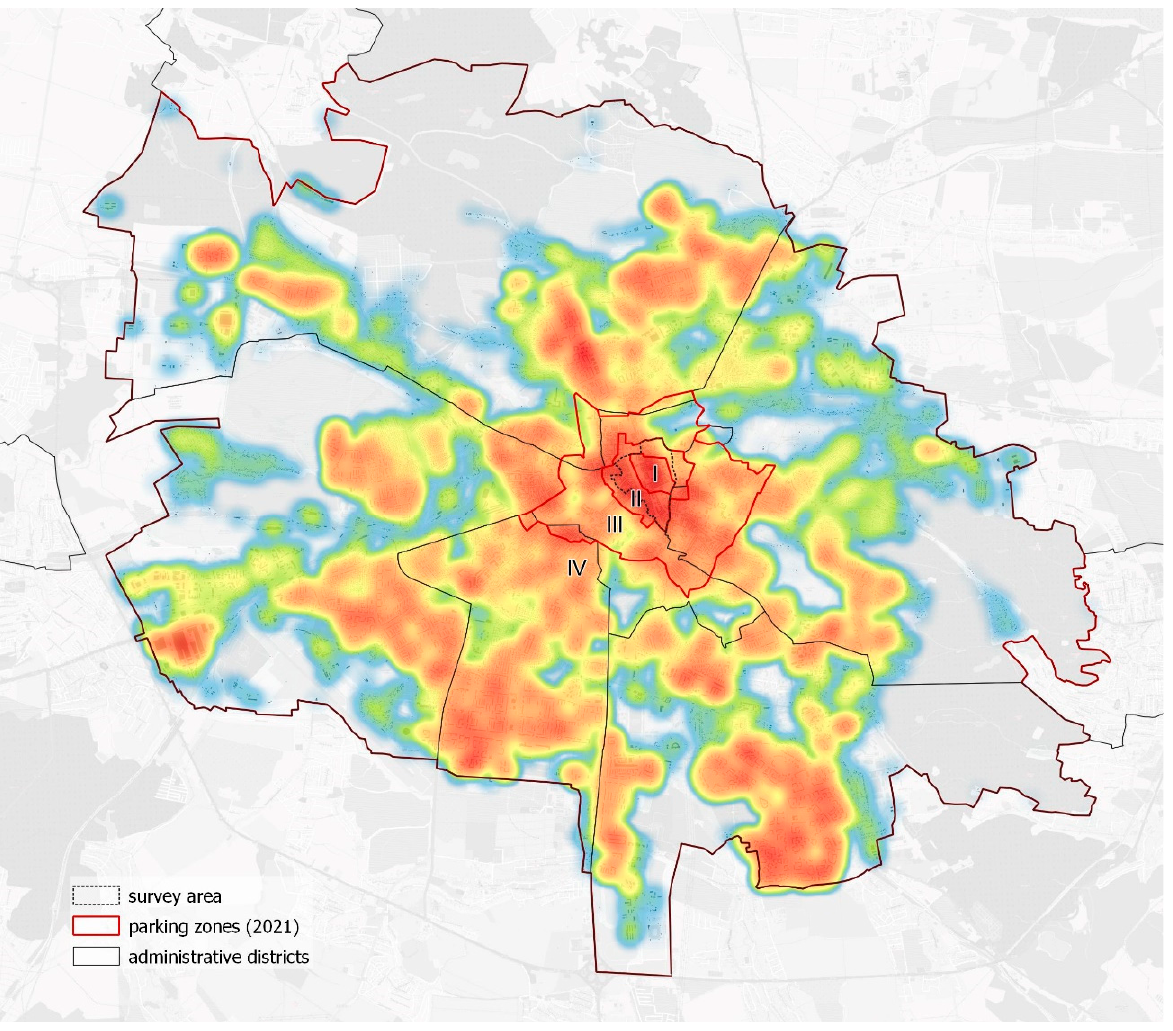
Figure 14. The population density diagram in Lviv with modern parking zones (it was constructed after processing the OpenStreetMap data according to [69].